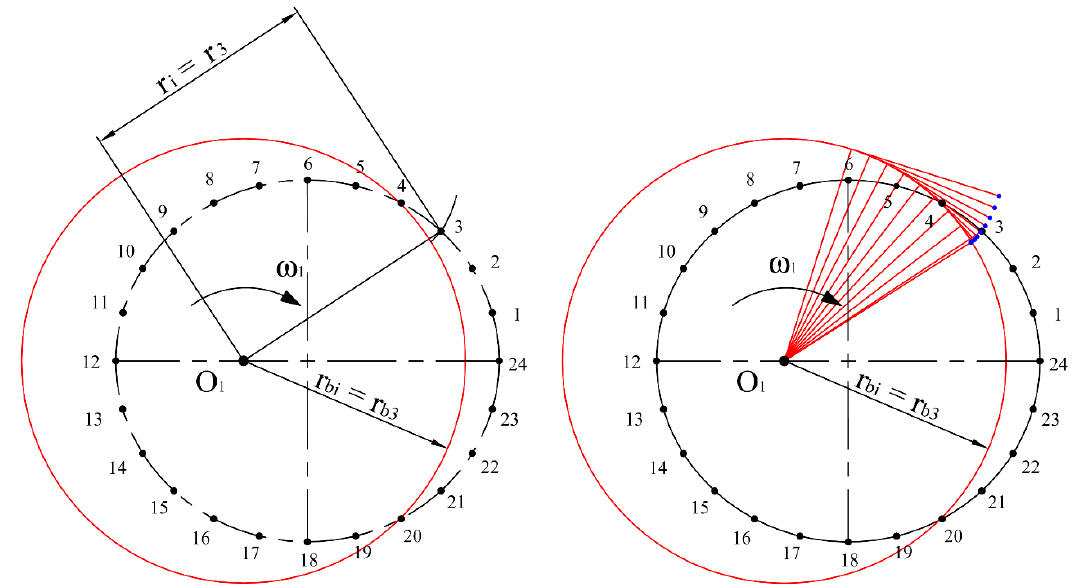
Figure 7. Example of involute construction from base circle for the tooth with order number 3. The diameters of the base circles for the left and the right side of a tooth are different.